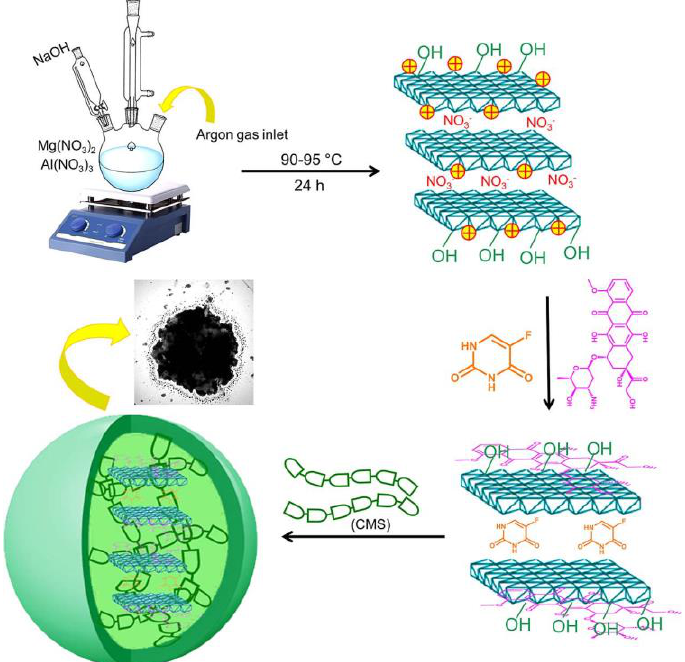
Figure 6. Graphic representation of the LDH(Mg – Al) production, co-drug payload, LDH(Mg- Al)@DOX,5-Fu coating with CMS, and the suggested method for the drug molecule releases from CMS@LDH(Mg – Al)@DOX,5-Fu microspheres. Adapted from Ranjbar et al. [44].